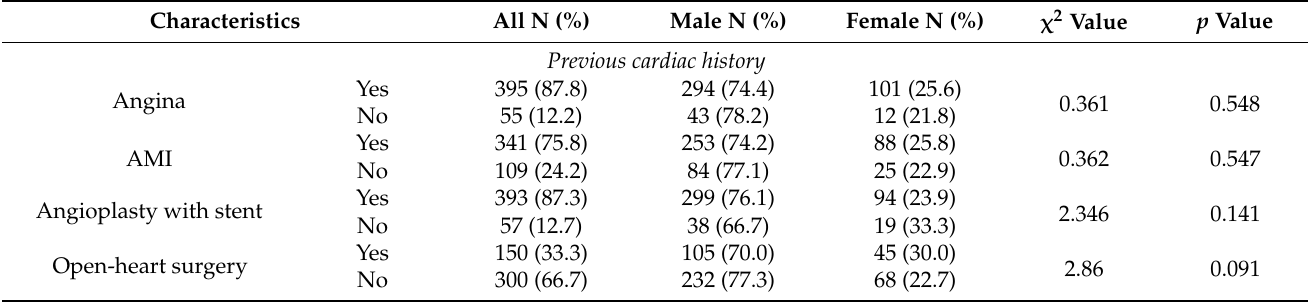
Table 3. Clinical characteristics of the